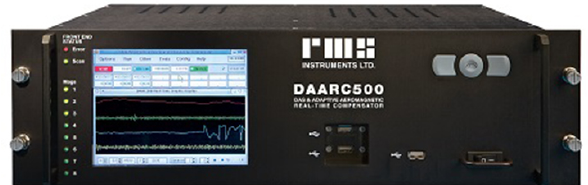
Figure 9. RMS DAARC500 compensation system (source: modi- fied from RMS 2015, http://www.rmsinst.com/images/DAARC500. jpg, last access: November 2015).